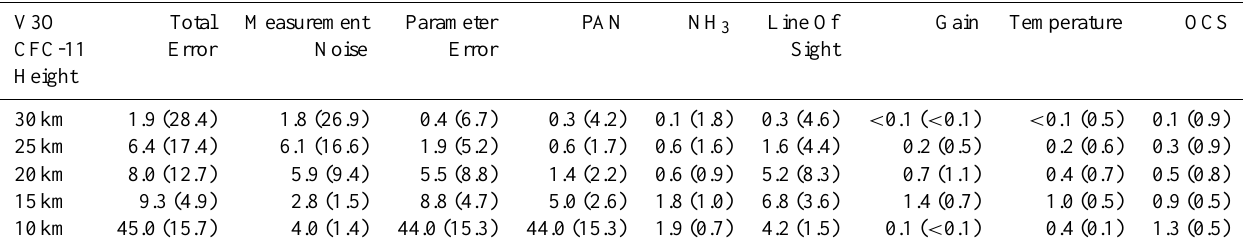
Table 2. Error budget of a V3O CFC11 10 (FR nominal mode) retrieval from spectra recorded at 63 ◦ S, 164 ◦ E on 21 May 2003 at 22:51 UTC, for selected altitudes. The errors are given in units of pptv(%). The total error is the sum of measurement noise and parameter error. The parameter error is the sum of uncertainties in interfering species and instrumental properties, which interact as random error sources (PAN, NH 3 , ..., OCS).